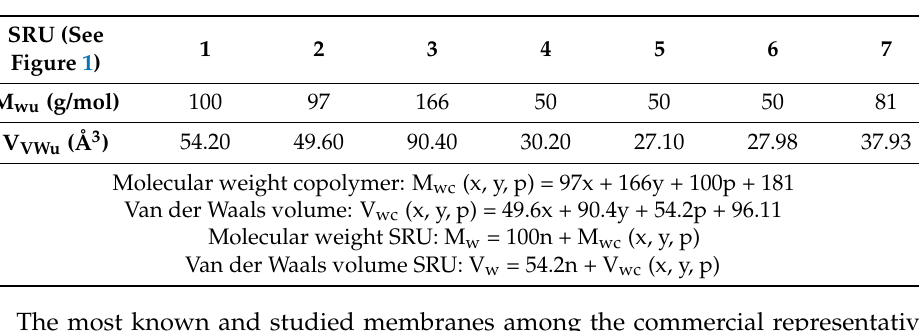
Figure 1. Structural repeating unit (SRU) for PFSA/polytetrafluoroethylene (PTFE) copolymers. Table 1. Molecular weight and Van der Waals volume for fragments in SRU.